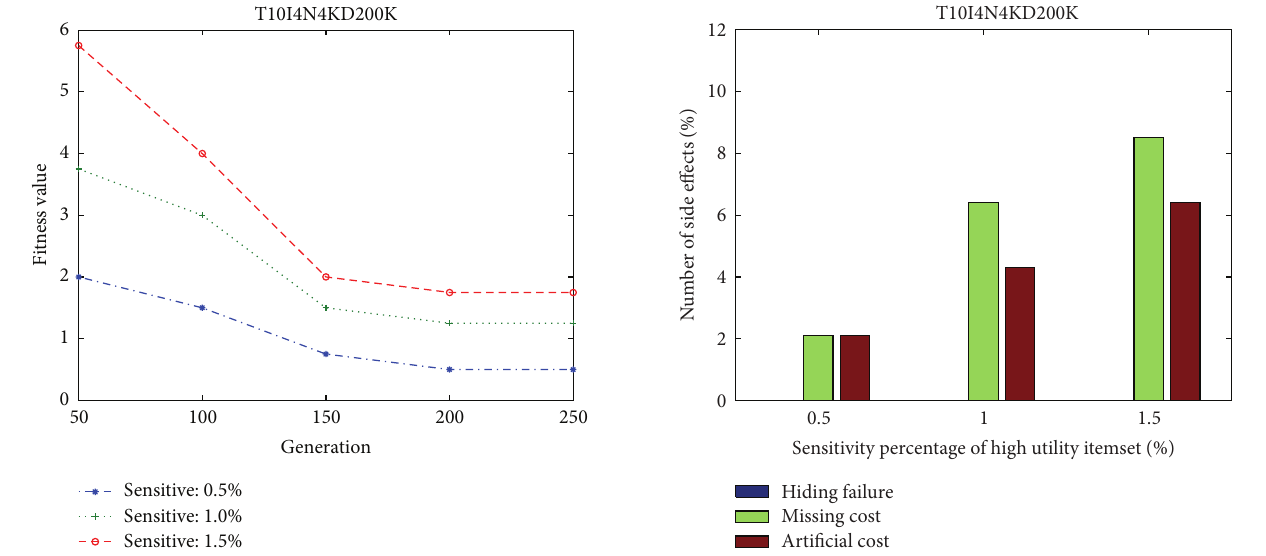
Figure 8: The evaluation of three side effects in simulation dataset.